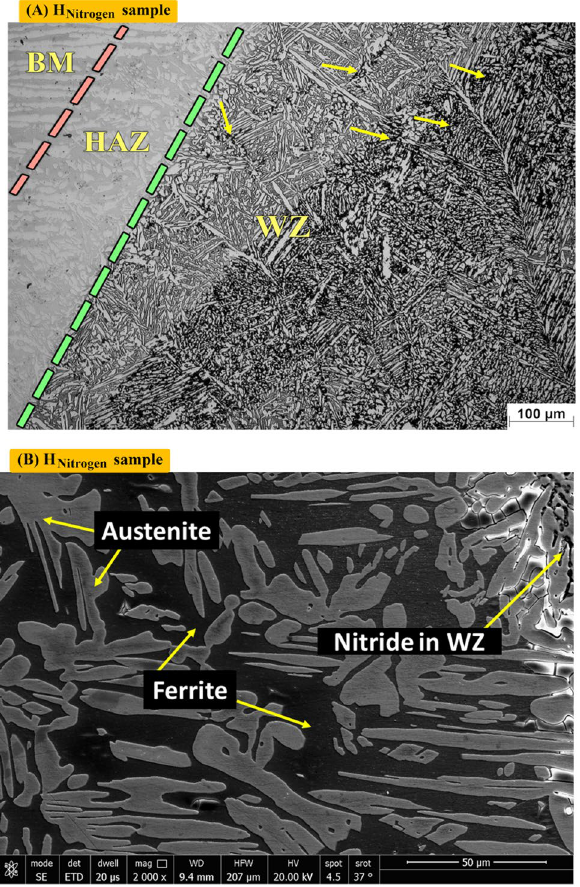
Figure 13. Optical and SEM micrographs of Heat effected zone of sample (H Nitrogen ) protected with Nitrogen gas during PWHT